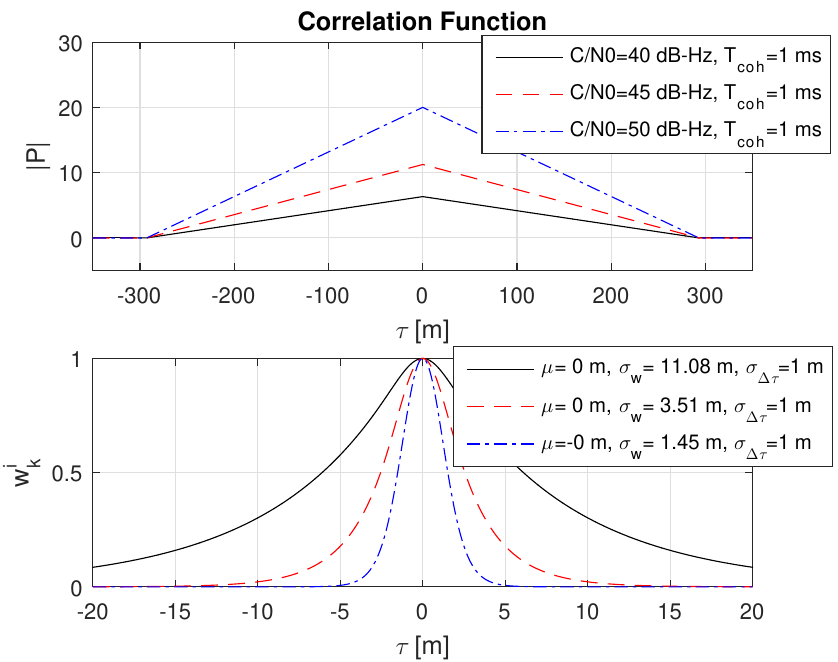
Figure 5. Impact of different GNSS signal amplitudes on the correlation values | P | and resulting probability function for a constant coherent integration time T coh and constant code delay bias standard devication σ ∆ τ . Higher signal strengths result in a smaller weighted standard deviation σ w of the probability